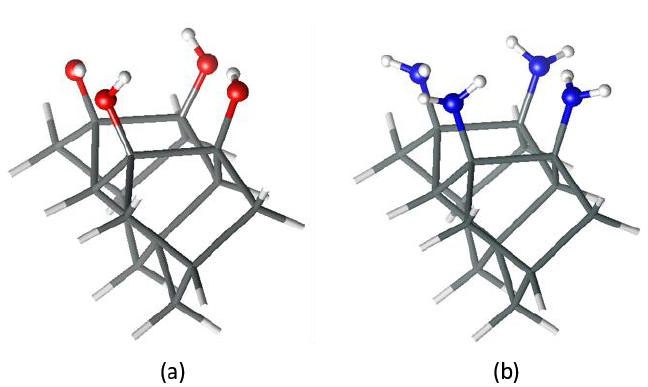
Figure 1. Cluster models: ( a ) –OH functionalized Si cluster; and ( b ) –NH 2 functionalized Si cluster (red = O, blue = N, white = H, green = Si).